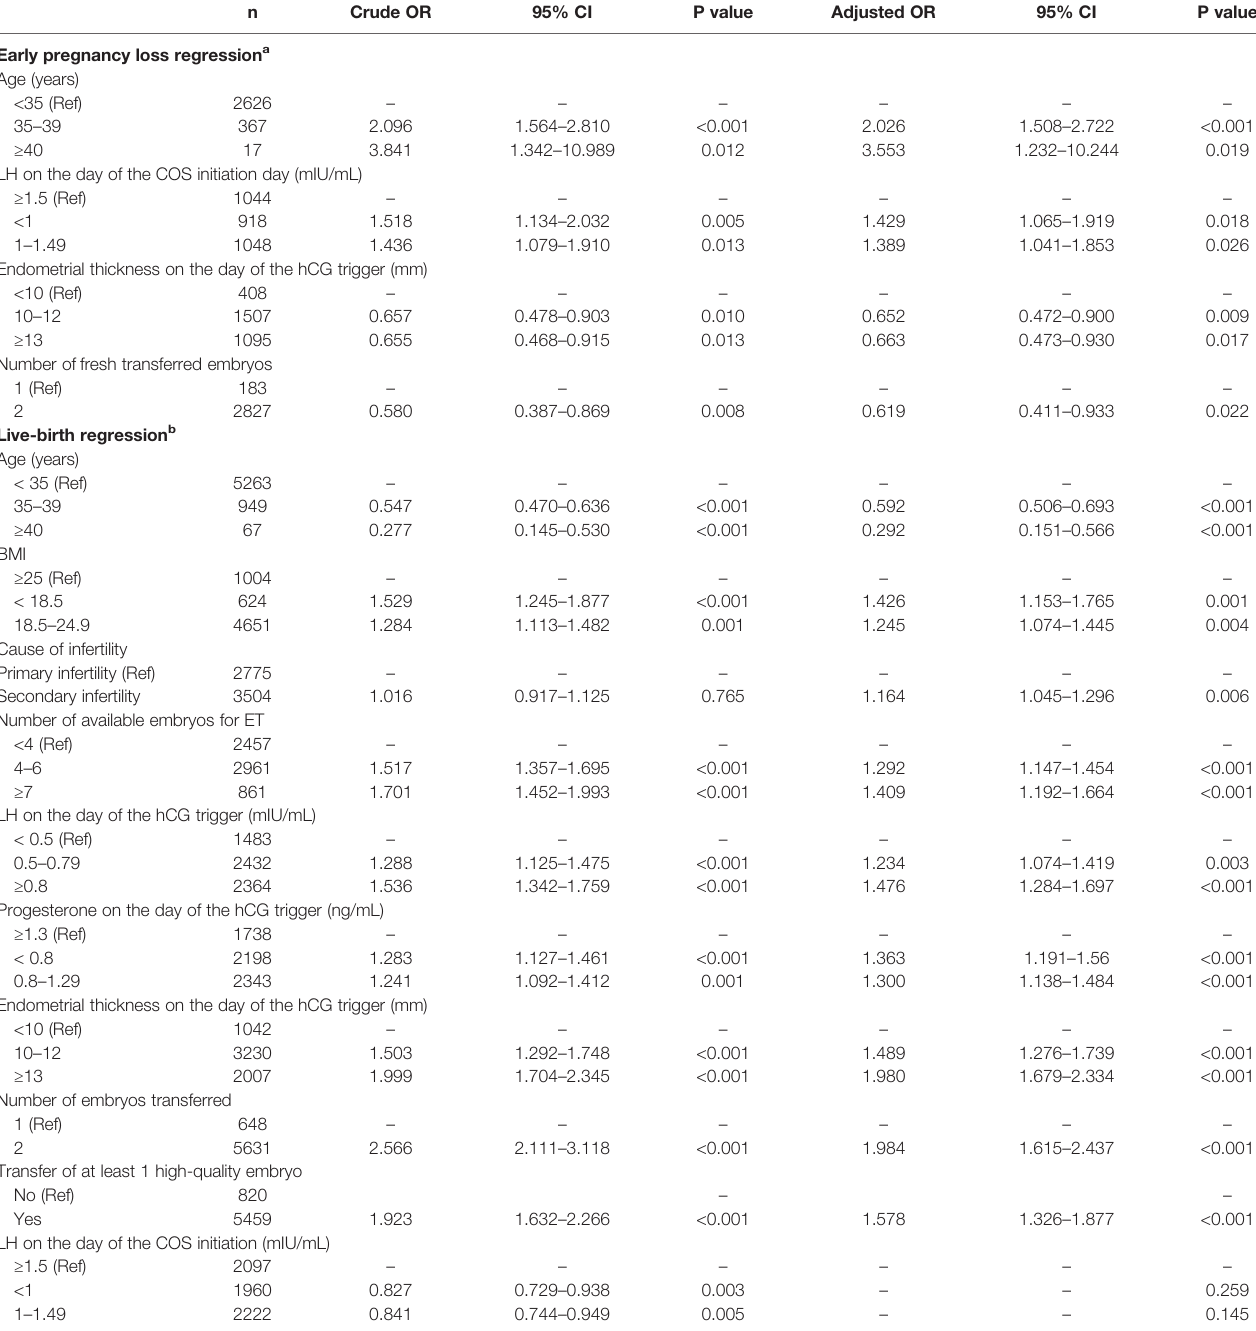
TABLE 3 | Univariate and multivariate analyses of early pregnancy loss and live births in fresh ET cycles. n Crude OR 95%